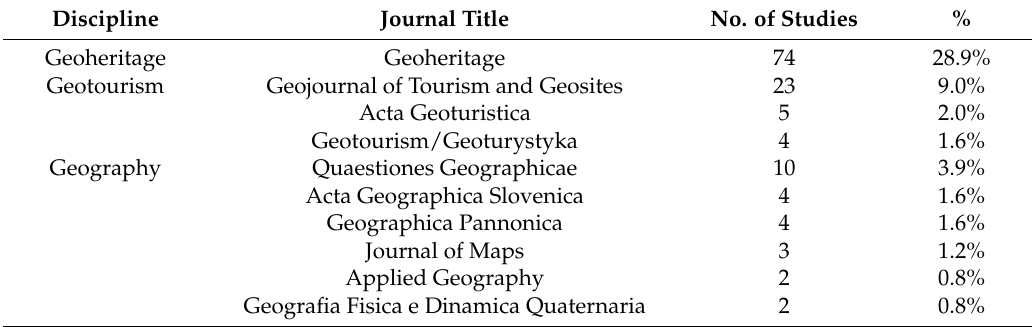
Table 1. Discipline and distribution of journals that published more than one paper on geotourism. Discipline